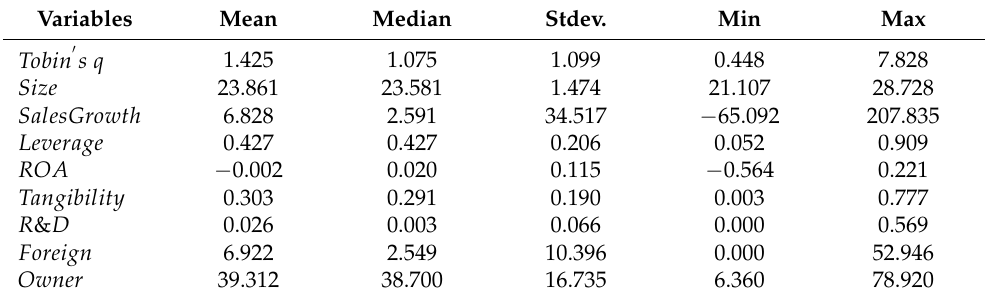
Table 4. Summary statistics ( N =